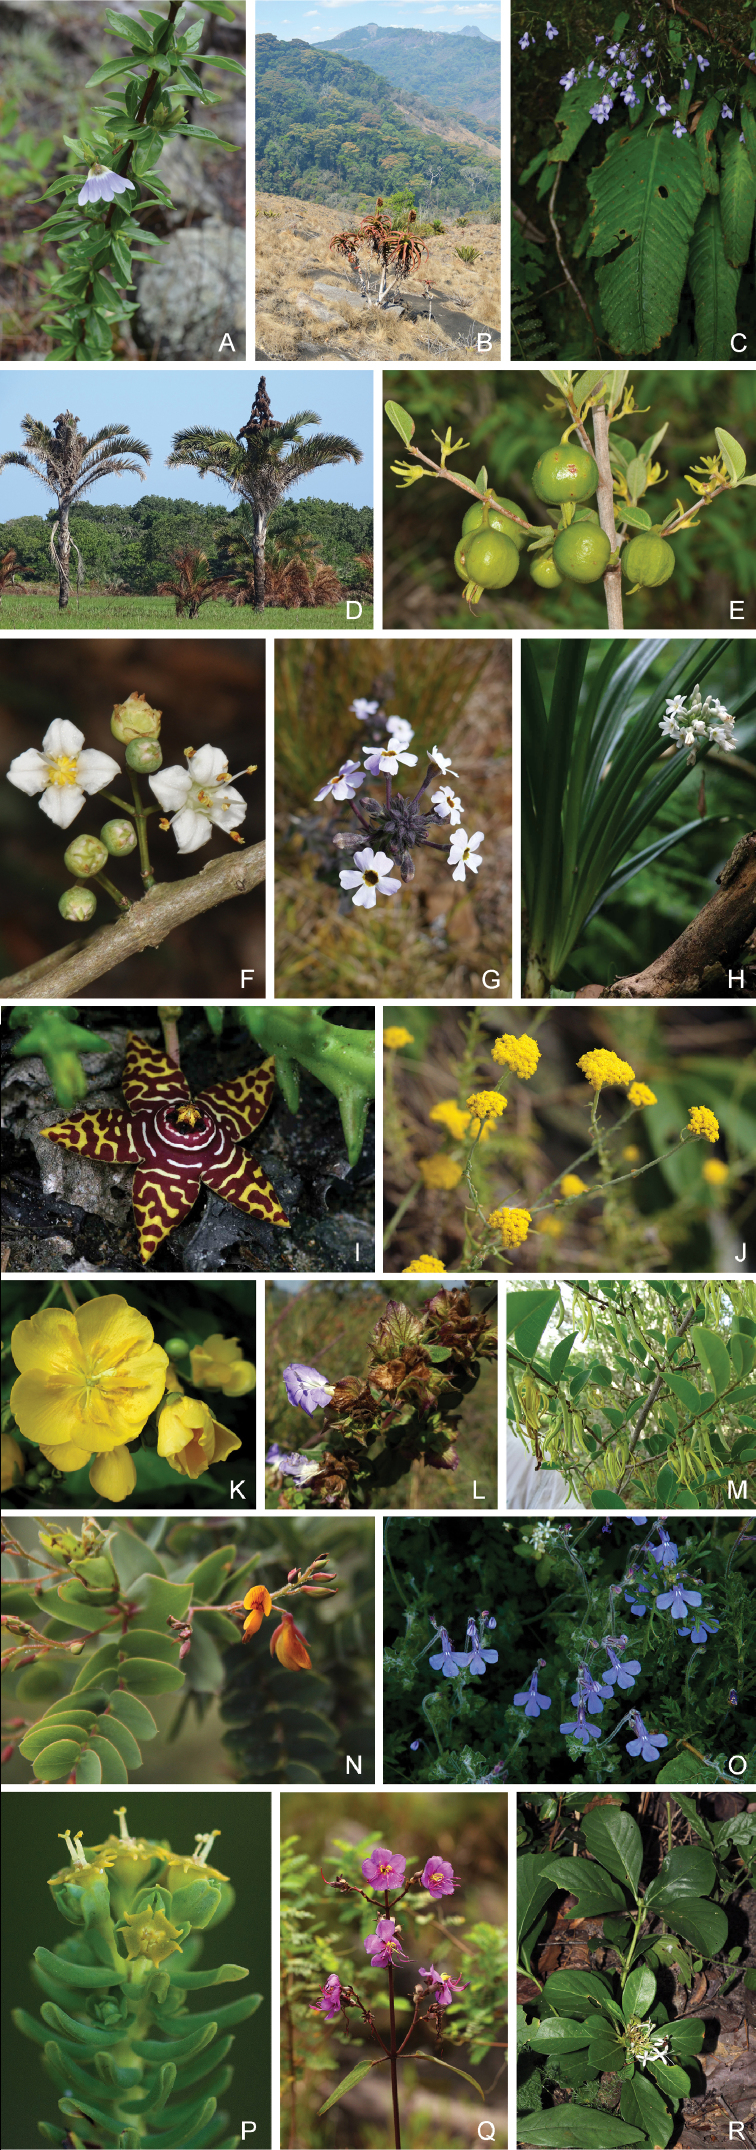
Examples of the strict-endemic and near-endemic plants of Mozambique. ASclerochiton
coeruleus, Maronga, Manica (I. Darbyshire) BAloe
ribauensis, Ribaue, Nampula (I. Darbyshire) CStreptocarpus
brachynema, Mount Gorongosa, Sofala (B. Wursten) DRaphia
australis, Bilene, Gaza (H. Matimele) EVangueria
monteiroi, Bilene, Gaza (H. Matimele) FMemecylon
incisilobum, Bilene, Gaza (H. Matimele) GJamesbrittenia
carvalhoi, Tsetserra, Manica (J. Osborne) HCryptostephanus
vansonii, Mount Gorongosa, Sofala (B. Wursten) IOrbea
halipedicola, Gorongosa National Park, Sofala (B. Wursten) JHelichrysum
moorei, Chimanimani Mountains, Manica (B. Wursten) KEriolaena
rulkensii, Palma Bay, Cabo Delgado (T. Rulkens) LBarleria
torrei, Njesi Plateau, Niassa (J. Osborne) MXylopia
torrei, Licuati Forest, Maputo (H. Matimele) NAeschynomene
grandistipulata, Chimanimani Mountains, Manica (B. Wursten) OLobelia
cobaltica, Chimanimani Mountains, Manica (B. Wursten) PEuphorbia
crebrifolia, Chimanimani Mountains, Manica (B. Wursten) QDissotis
pulchra, Chimanimani Mountains, Manica (B. Wursten) RPavetta
pumila, Cheringoma, Sofala (B. Wursten).